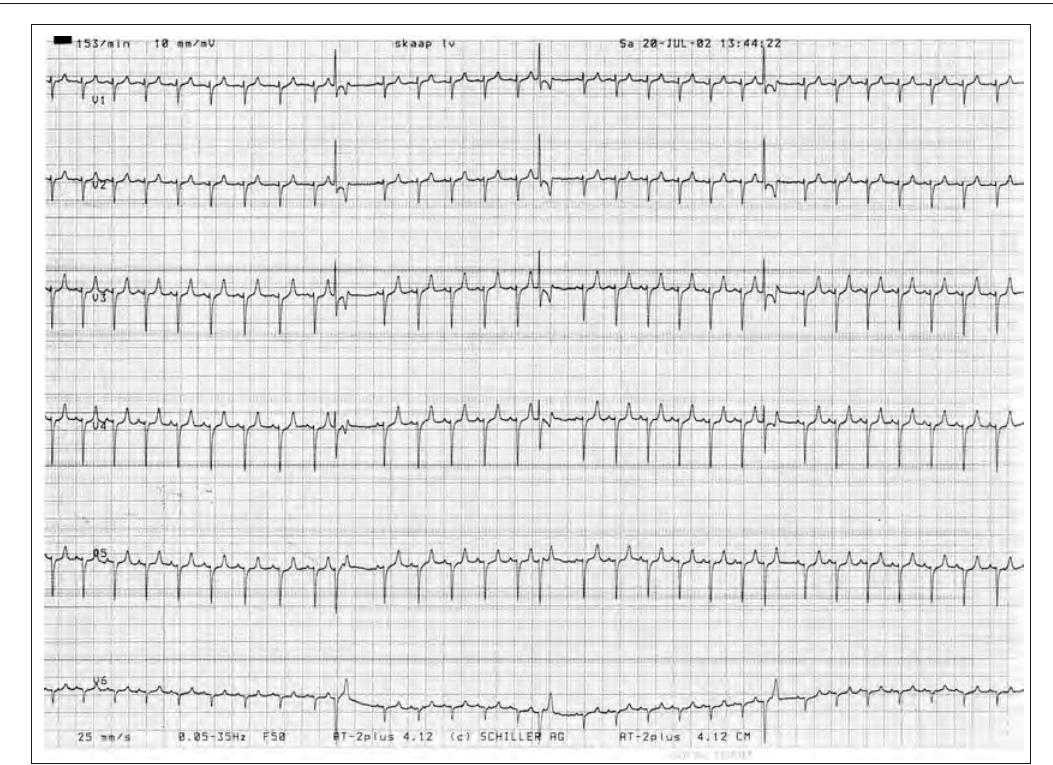
FIG. 2 Note the 3 PVCs with a positive QRS polarity in Lead V1 and a negative polarity in Lead V6